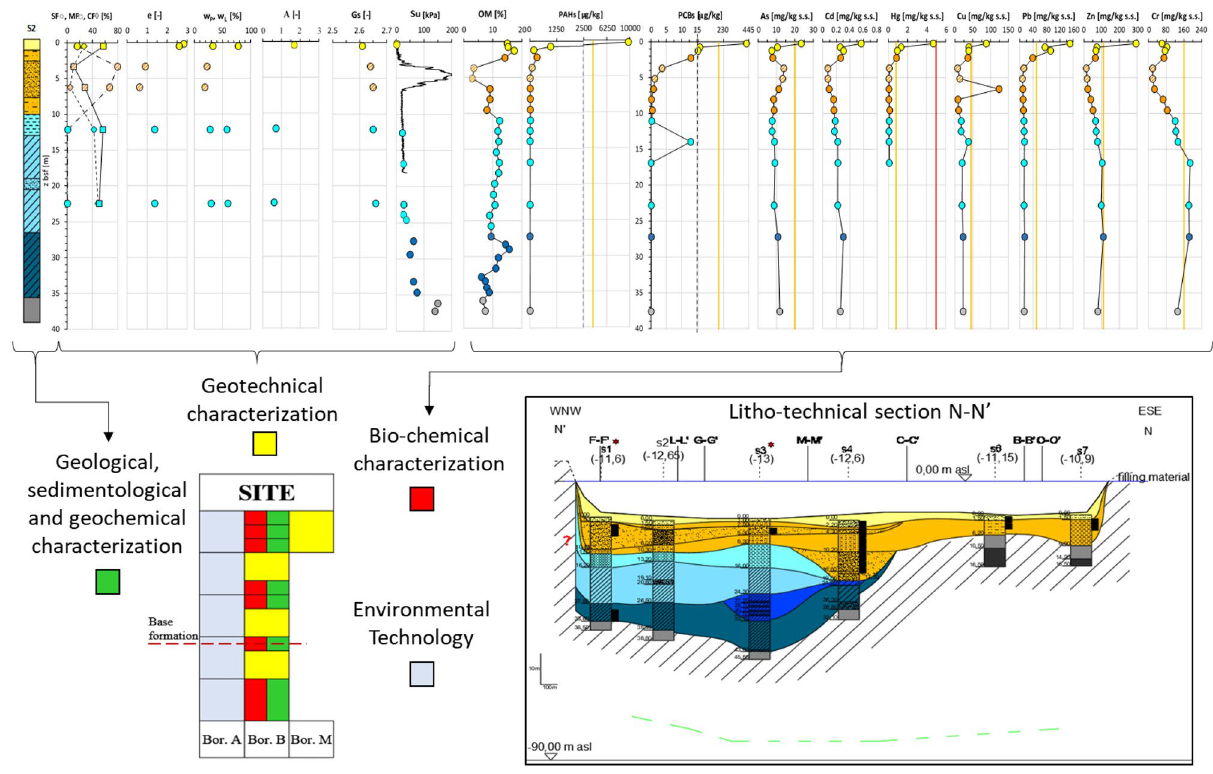
Figure 6. Schematic outline of the combination of the results from the different testing fields performed in the sediments retrieved in the investigation